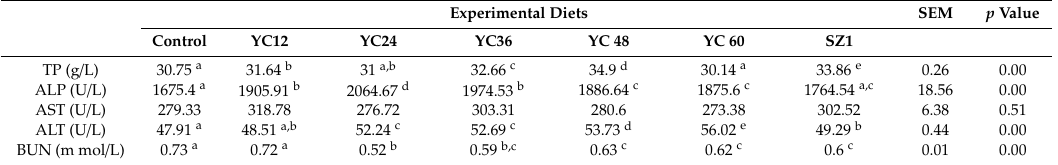
Table 4. E ff ects of dietary fermentation time of yeast culture on some plasma biochemical parameters of broilers over 42